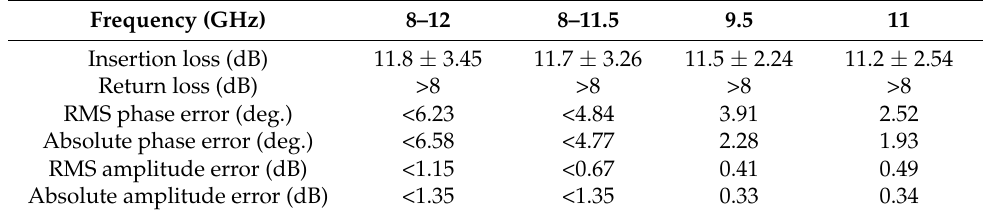
Figure 10. ( a ) RMS phase error and RMS amplitude error; ( b ) absolute phase error and absolute amplitude error of the 32 states of phase shifter. Table 2. Measurement results for the 5-bit phase